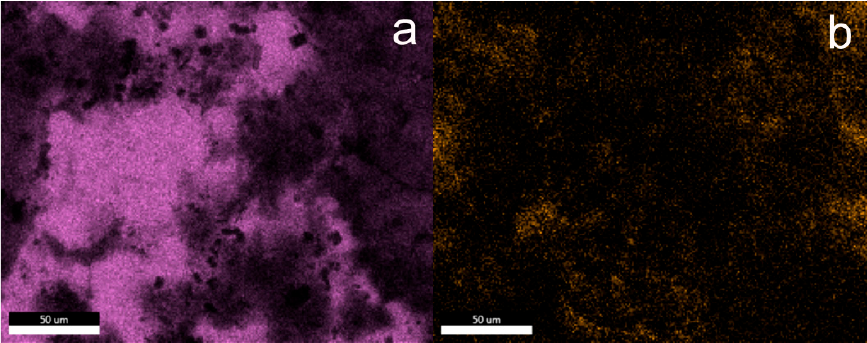
Figure 3. EDS mapping of the elements on the F5 surface; element map of Si ( a ) and F ( b ).